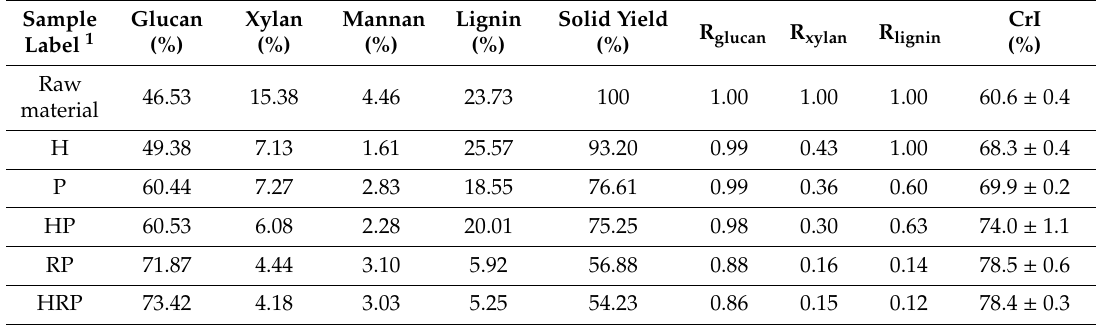
Table 1. Chemical composition and crystallinity index of the poplar wood samples under di ff erent treatment